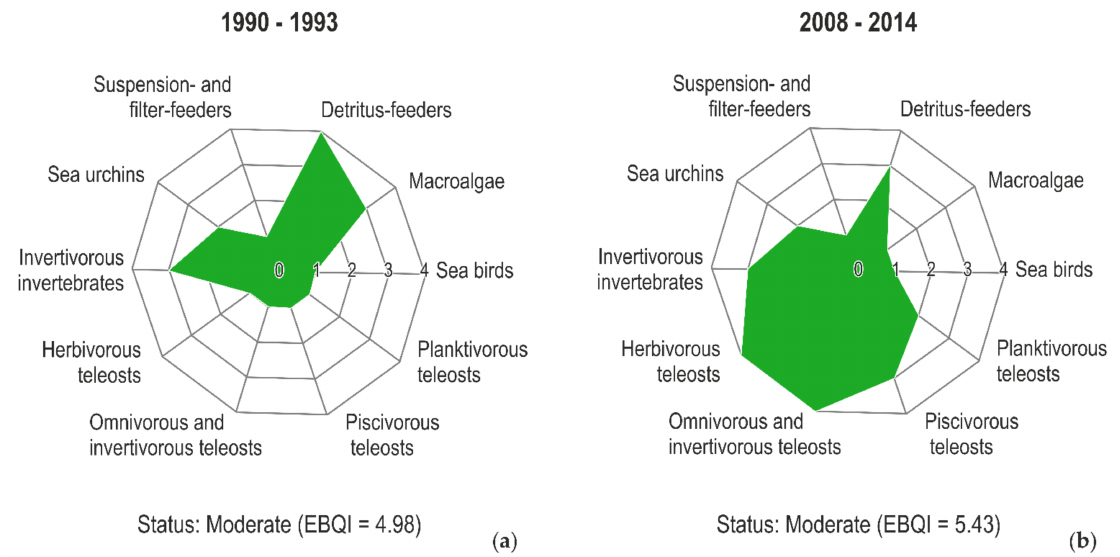
Figure 7. Ecosystem-based ecological assessment of the rocky reefs of Portofino, in the Ligurian Sea, before ( a ) and after ( b ) the institution of the MPA. The spider-web graphics represent the ecological status(semi-quantitative scale from 0 = bad to 4 = high) of each compartment of the ecosystem. EBQI = Ecosystem-Based Quality Index. Redrawn and modified from